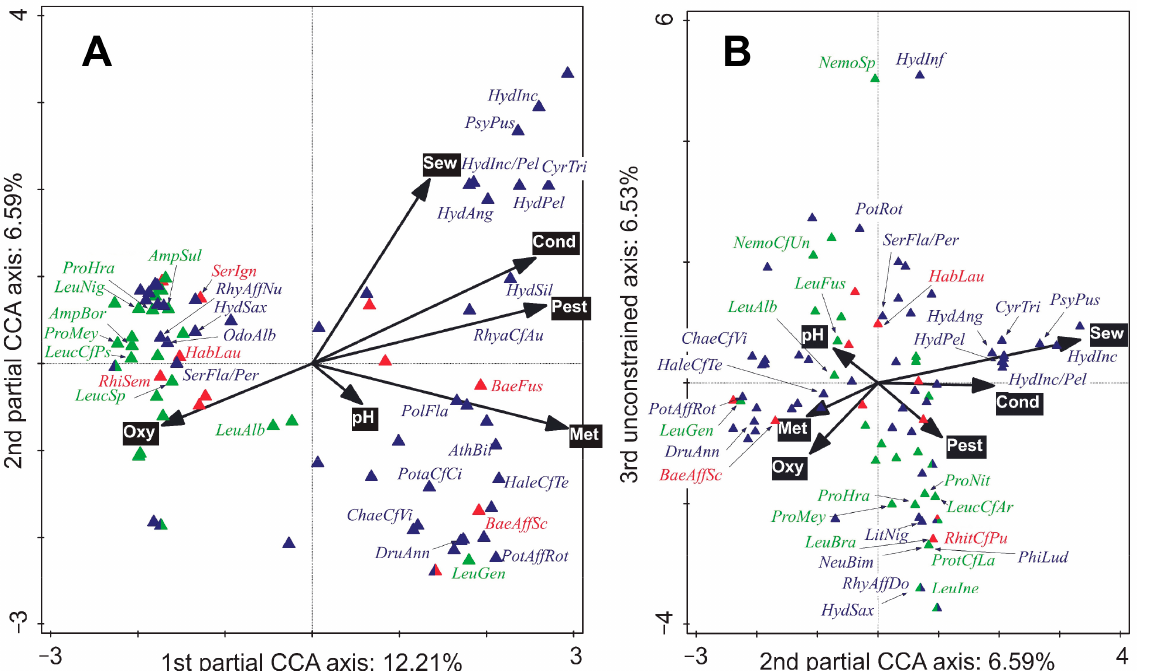
Figure 3. Species + whole-plot environmental variables (EVs) biplots: the first 33 best fitting species are labelled (Ephemeroptera, Plecoptera, and Trichoptera labelled in red, green, and blue, respec- tively). A partial canonical correspondence analysis (CCA) was used: ( A ) first and second ordination axes; ( B ) second and third ordination axes. Ordination axes were constrained by the EVs selected by forward selection, which accounted for 30.48% of the explained variation. Test on first axis: pseudo- F = 0.5, p = 0.001; test on all axes: pseudo- F = 2.3, p = 0.001. Conditional effects (from the greatest to the lowest explained variation): ‘Log-transformed sum of cadmium, lead and zinc (Met)’: